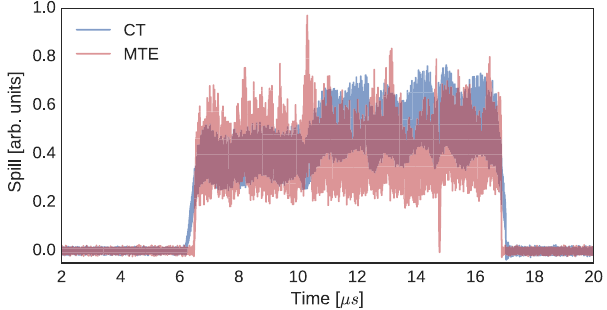
FIG. 11. Example spills for both CT and MTE.